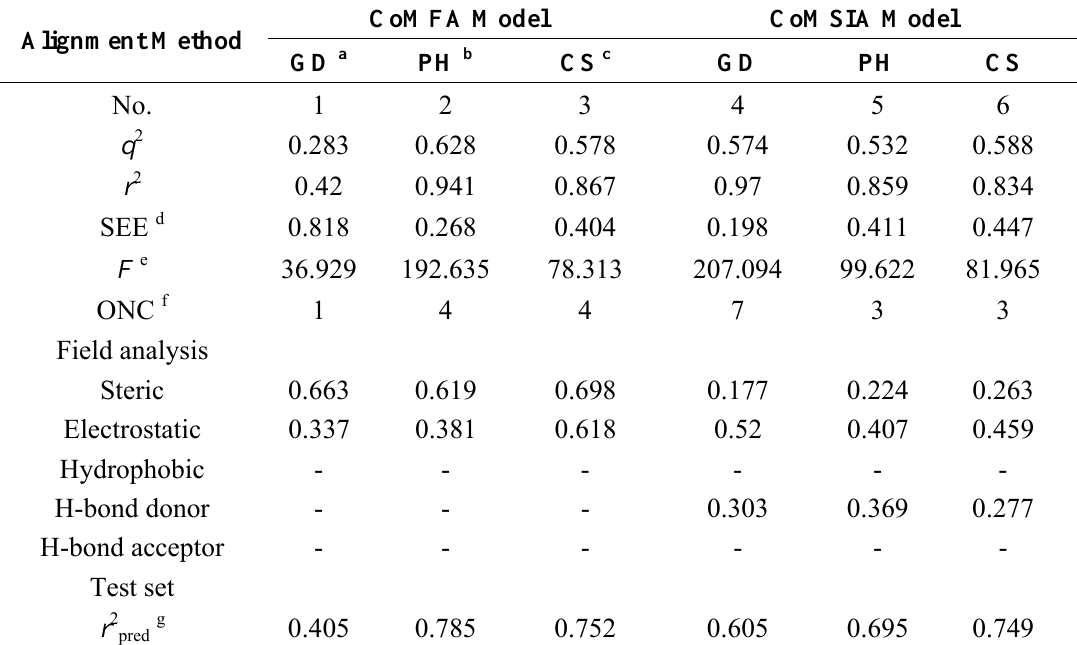
Table 2. Statistics summary of CoMFA and CoMSIA